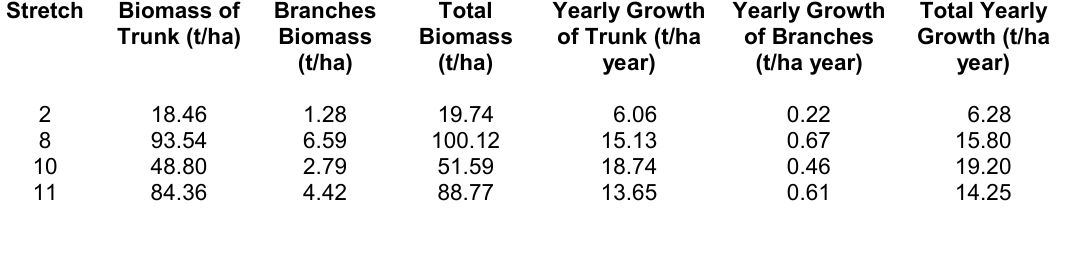
Distribution of Individual Trees within Diametric